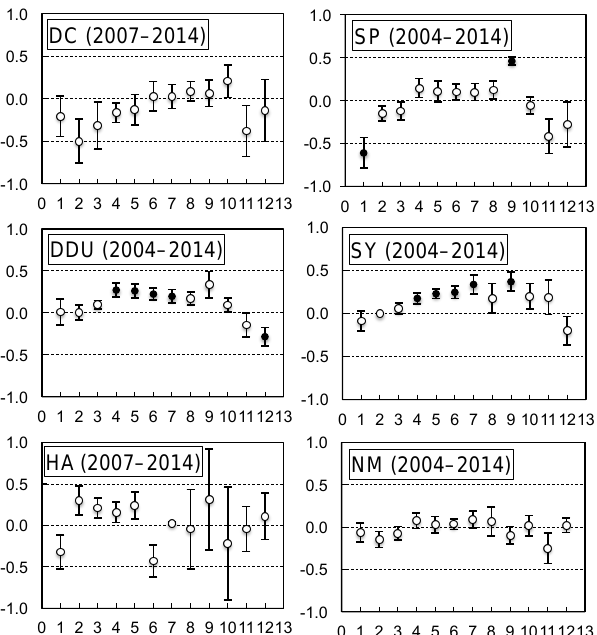
Figure 16. Monthly slopes of the linear regression lines of ozone trends analyses (in ppbvyr − 1 ) at Concordia (DC), South Pole (SP), Dumont d’Urville (DDU), Syowa (SY), Halley (HA), and Neu- mayer (NM). Black circles denote slope values that are statistically different from zero at P > 95%. Vertical bars refer to standard er- rors of the regression